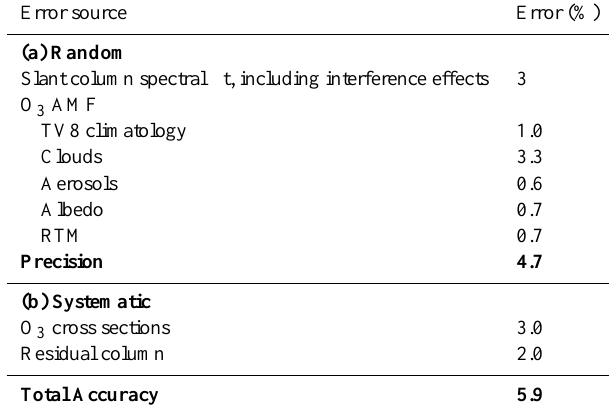
Table 4. Error budget of zenith-sky total O 3 columns measurements in the visible